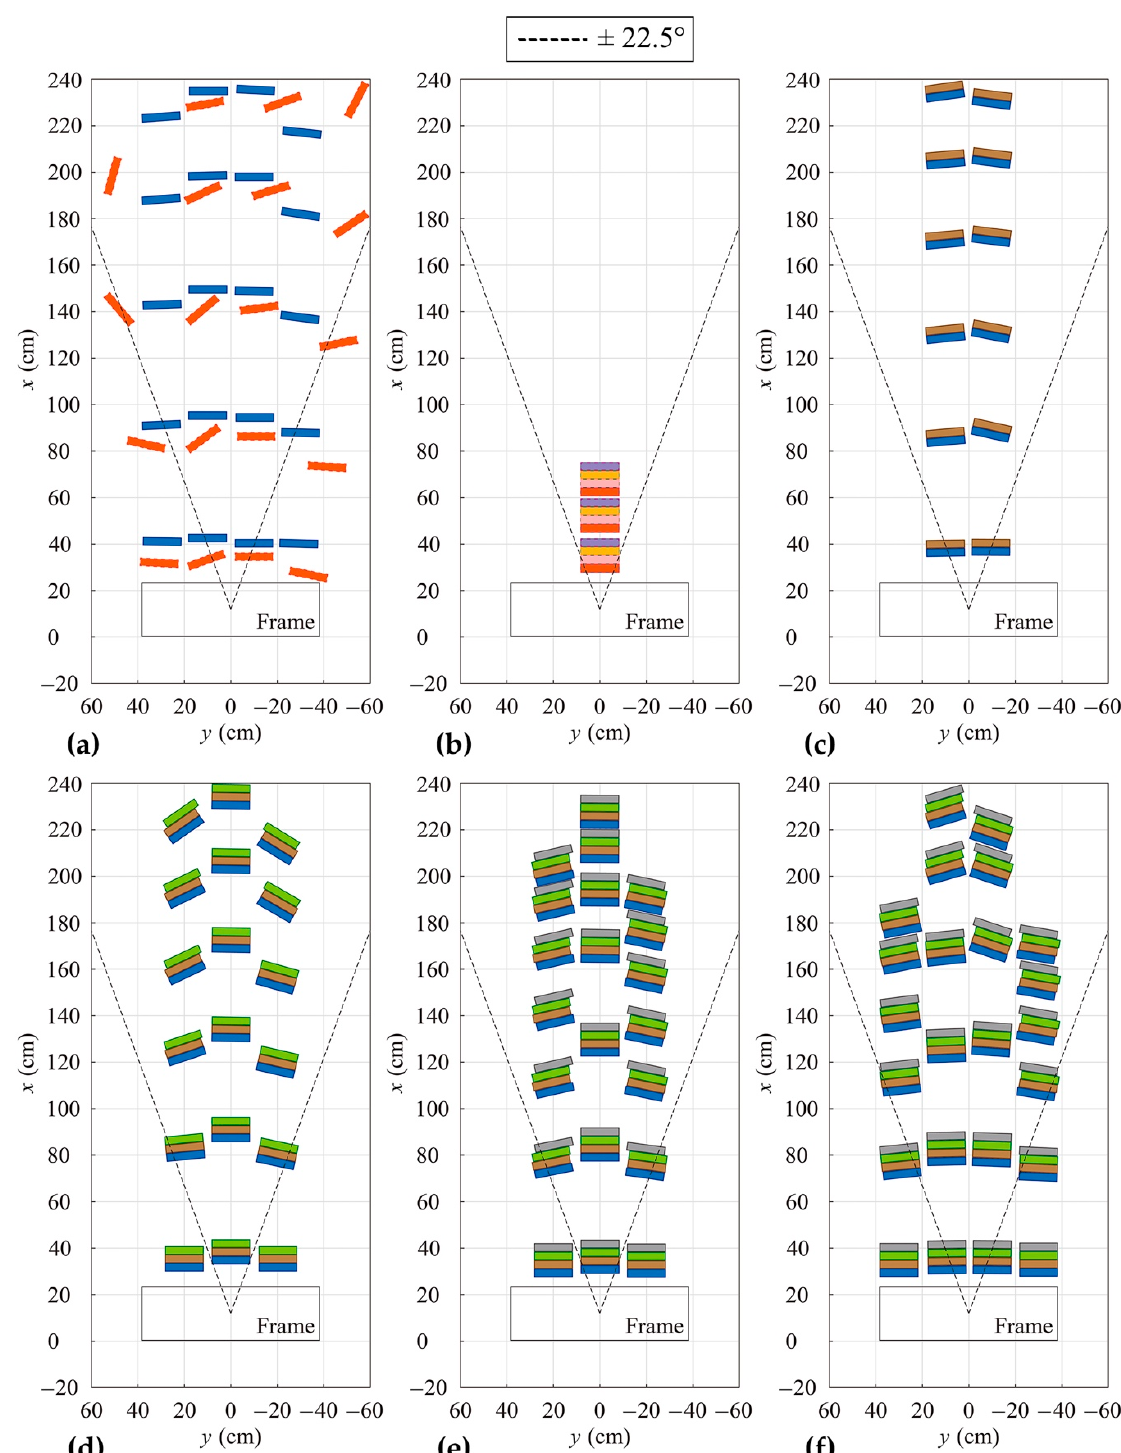
Figure 19. Location of the multiple container trajectories after starting the drift at a 0.4 s interval in the ( x , y ) plane. The solid blue-brown-green-grey containers are the Z 1 layers of columns X 1, X 2, X 3, and X 4, respectively. The dotted orange-pink-yellow-purple containers are the Z 2 layers of columns X 1, X 2, X 3, and X 4, respectively. The hollow quadrilateral box demonstrates the framework this work used for the initial placement of containers. Each dark dashed line demonstrates the spreading angle suggested by Equation (1) [16]. Configurations ( a ) 14290; ( b ) 41290; ( c ) 22190; ( d ) 33190; ( e ) 43190; and ( f ) 44190.